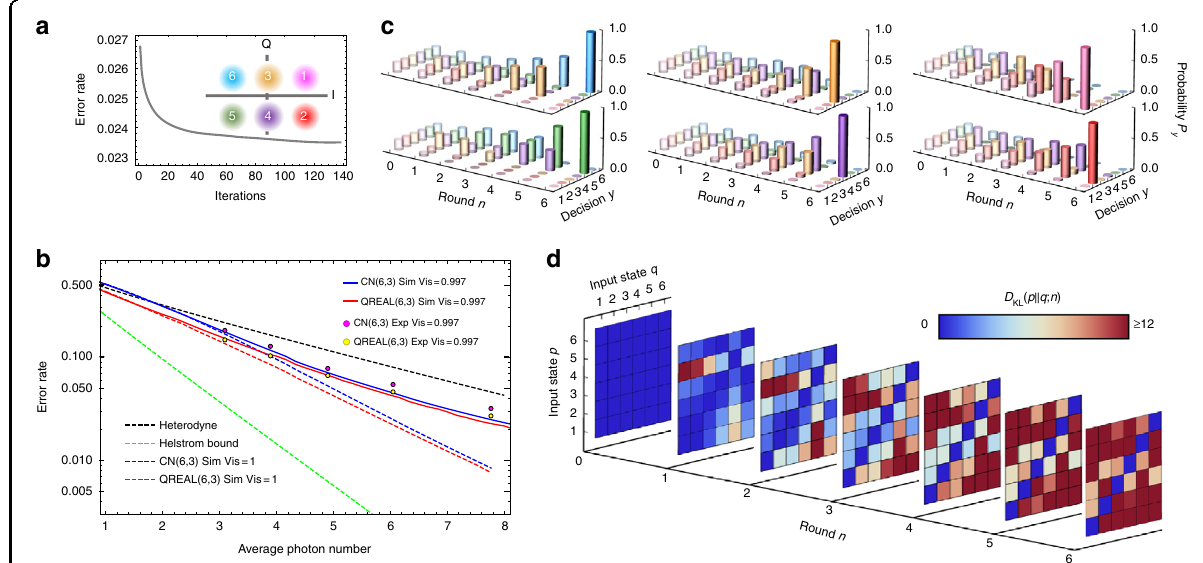
Fig. 3 QREAL for QAM-encoded quantum-state discrimination. a Evolution of error rate during learning iterations. Inset: constellation of QAM-6 encoding. b Comparison of the error rates for QREAL and other receivers in the presence of noise. An interference visibility of 99.7% is set in simulations (solid lines) and is measured in experiments (points) for all tested receivers. Dashed lines are simulated error-rate lower bounds without noise. c Posterior probabilities for input quantum states in different rounds. The uniform prior probabilities are plotted in Round 0. The position arrangement and color of states follows the inset in a . d Evolution of the relative entropy D KL ð p jj q ; n Þ (Kullback-Leibler divergence) for the pair-wise i and j β i . Mean photon number used in fi gure a , c , and d is measurement statistics conditioned on the input quantum states j β p q